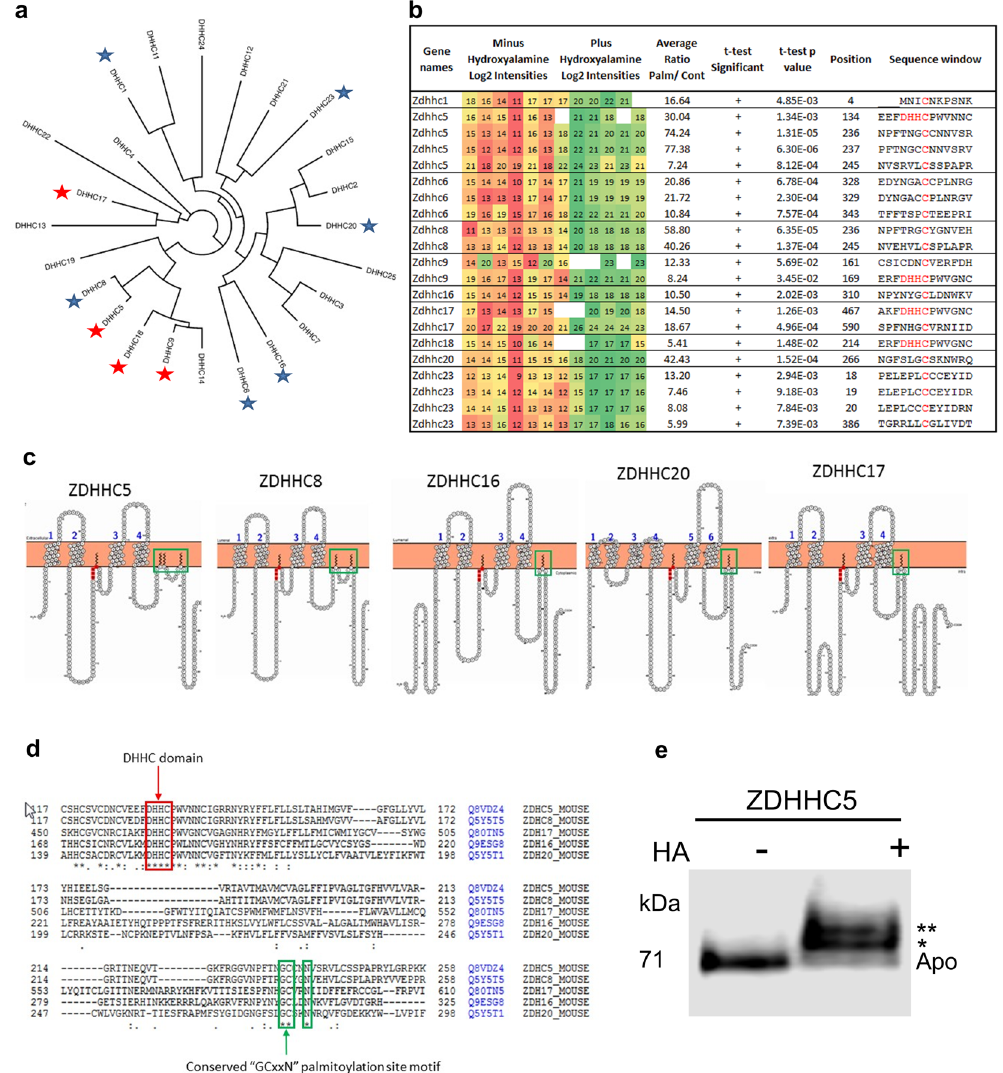
Figure 6. Palmitoylation of protein acyltransferases. ( a ) 21 palmitoylation sites were identified on 10 (starred) out of 23 known DHHC-domain containing protein acyltransferases. ( b ) Relative intensities of peptides identifying these modifications are shown in + / − hydroxylamine treated sets. All detected potential palmitoylation sites for PATs were significantly enriched over control purifications in ssABE experiments. ( c , d ) Palmitoylated active site intermediates were detected for 4 PATs (starred red in ( a )) and additional non- active site palmitoylation was found for 9 PATs, a subset of which was in a conserved “GC * xxN” motif in 5 PATs ( c ). ( e ) PEG switch assay of endogenous mouse brain DHHC5. Band shifts corresponding to the addition of 5 kDa PEG groups to sites of palmitoylation sensitive to hydroxylamine HA) treatment allow the detection of at least two palmitoylated forms of DHHC5 thus confirming that it is also palmitoylated at sites other than the active site cysteine residue. An uncropped image of this PEG switch blot is presented in Figure